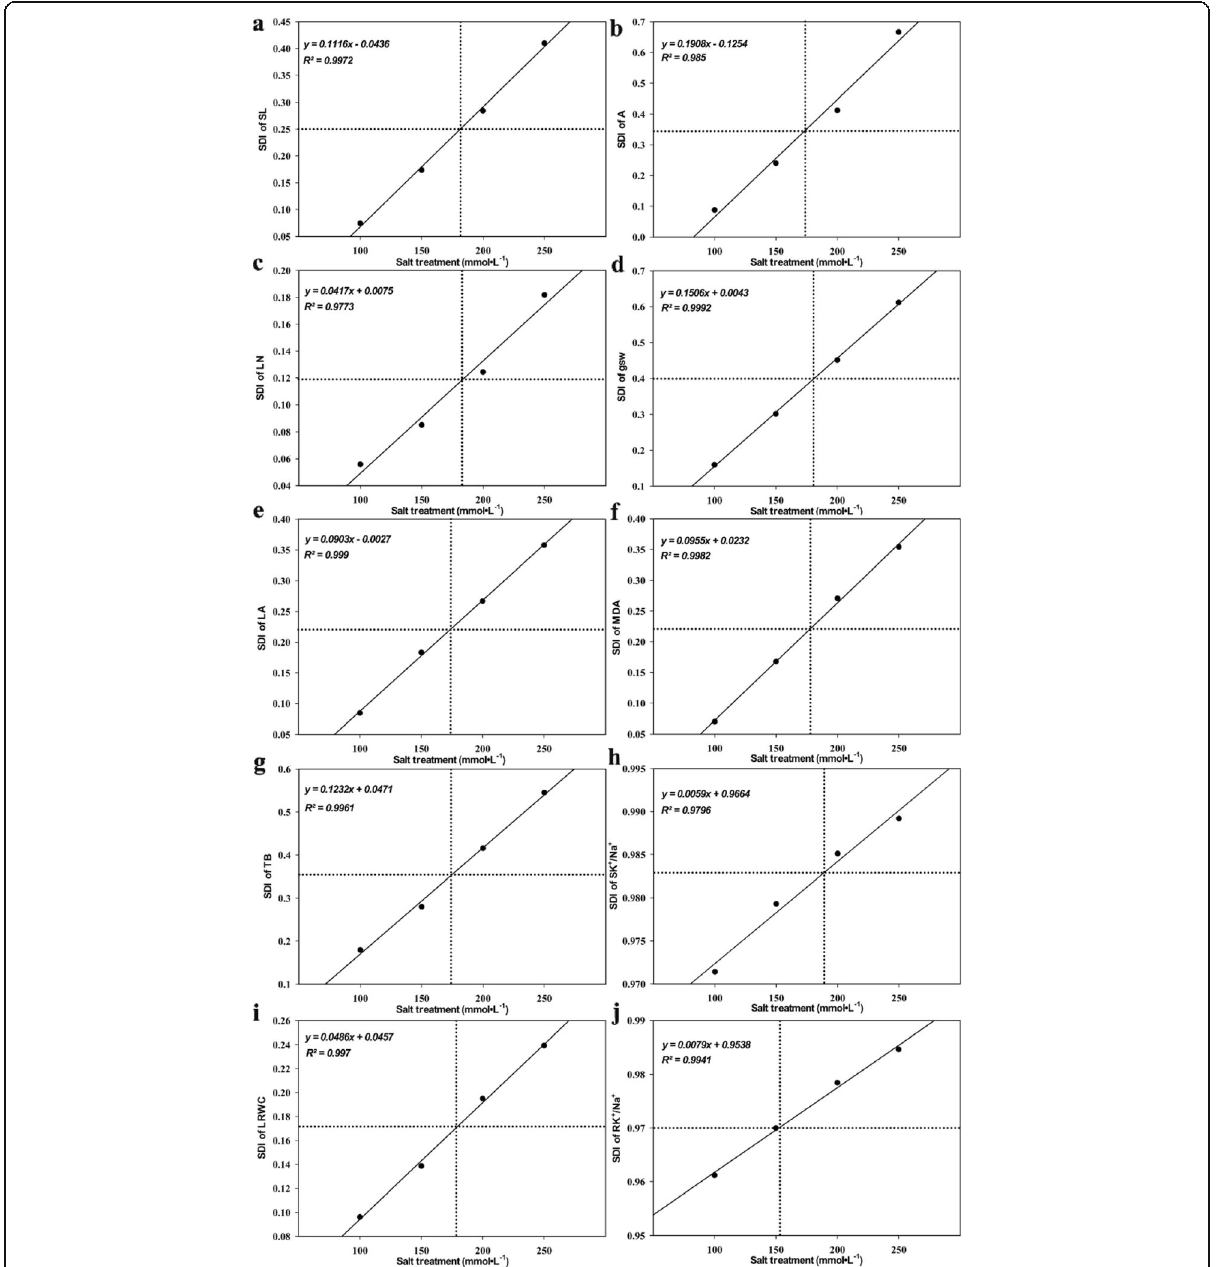
Fig. 2 Determination of optimal salt concentration for assessing salt tolerance. The salt concentration of the SDI is the half of each morpho- physiological trait of cotton